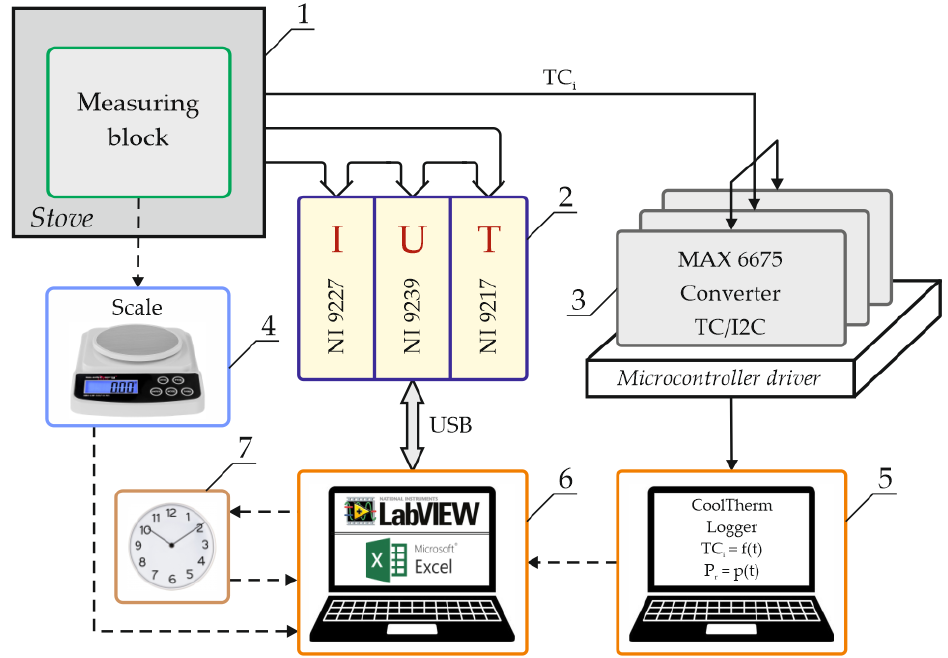
Figure 1. Scheme of the test stand. Number 1 — measuring block shown separately in Figure 3; 2 — LabView cassette for cyclic measurements of electrical parameters and current temperatures; 3 — microcontroller for temperature measurements using thermocouples; 4 — scale for measuring the mass of elements included in the measuring block; 5 — computer archiving data from thermocou- ples; 6 — computer archiving data from the LabView cassette; 7 — internal clock in the